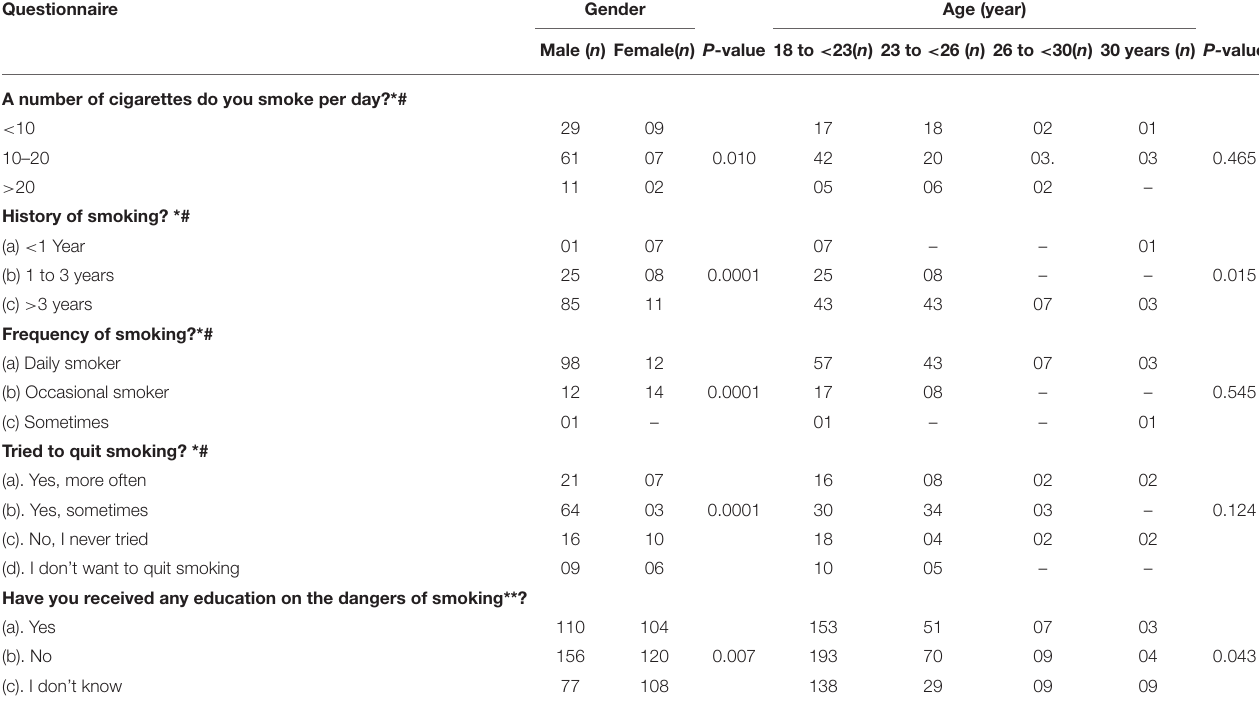
TABLE 5 | The association between smokers, smoking behaviors with respect to age, gender.